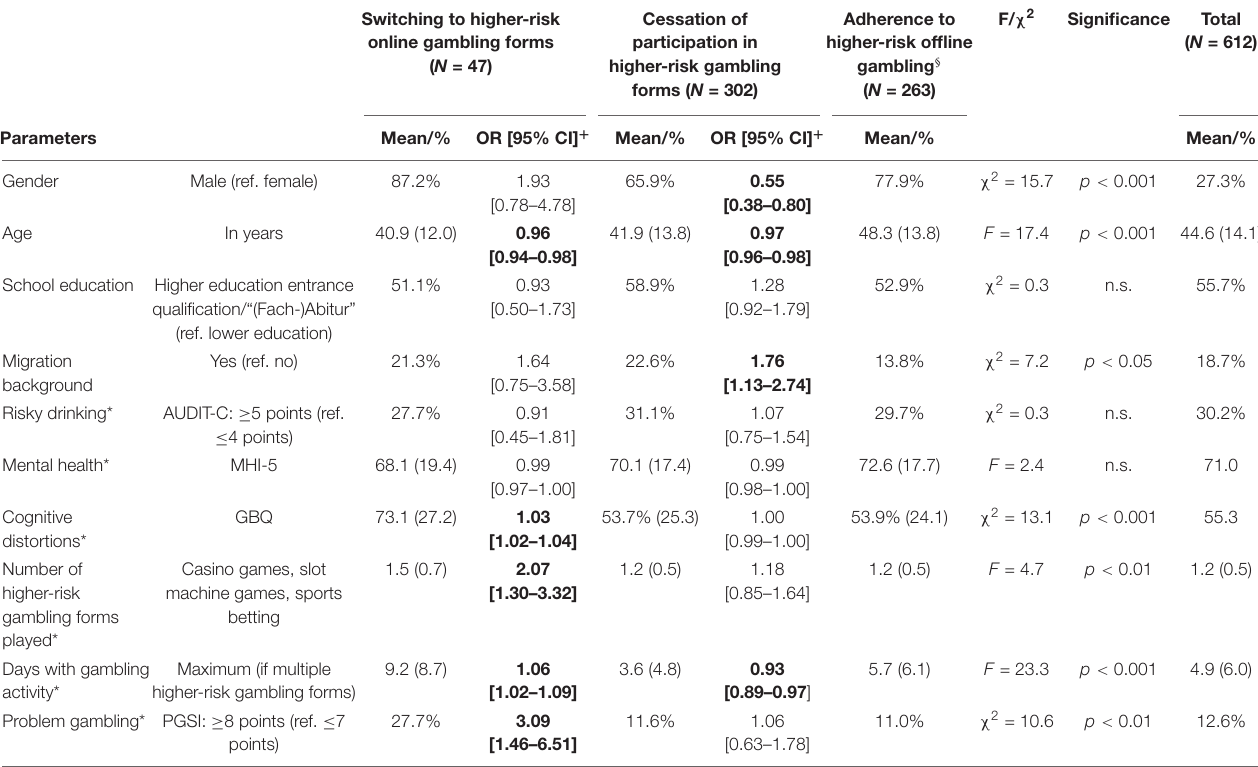
TABLE 1 | Parameters for changes in gambling behavior between the periods before and after the first lockdown – comparison of gambling groups (univariate multinomial logistic regression). Switching to higher-risk online gambling forms